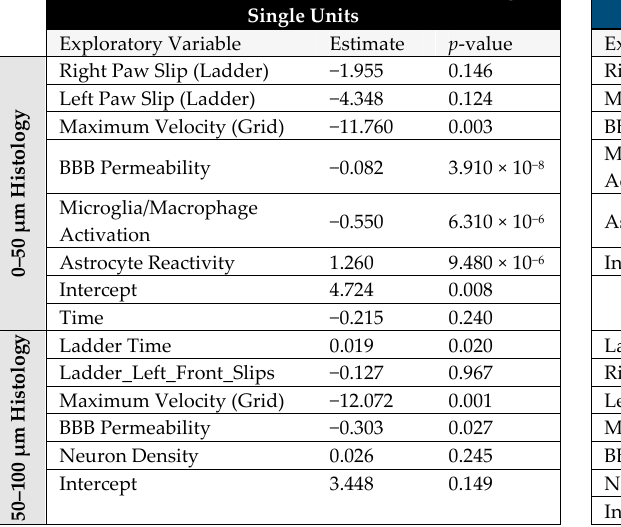
Table 3. Estimated Coe ffi cients and Significance of Exploratory Variables. The table below portrays the variables included in the pairwise correlations using the linear mixed e ff ects models and their resulting estimates and p-values in relation to either the percentage of channels recording single units or the units per channel outcome variables. n = 6.